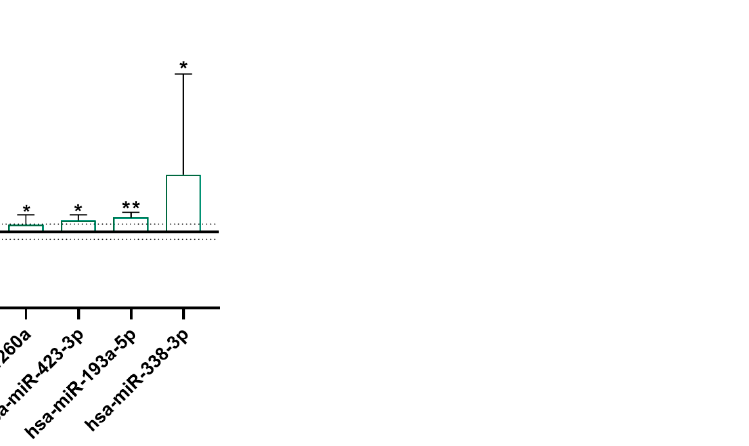
Figure 2. Serum miRNA deregulation in severe asthmatic patients treated with anti-IL-5 drugs. Among the nine patients analyzed, five were severe asthmatics treated with mepolizumab and four with reslizumab. Eosinophilic asthmatic patients showed an altered expression of miR-195-5p, miR-27b-3p, miR-1260a, miR-423-3p, miR-193a-5p, and miR-338-3p at eight weeks after anti-IL-5 administration. Relative miRNA expression is expressed as 2 − ∆∆ Ct . * p < 0.05, ** p < 0.01. Afterward, these results were validated by RT-qPCR of serum samples from 16 se- vere asthmatics. Nine of them were the same patients that we used in the miRNA PCR array, and the rest were different patients treated with mepolizumab or reslizumab. We confirmed that only miR-338-3p was significantly upregulated ( p < 0.05) in these patients after 8 weeks of treatment (Figure 3).